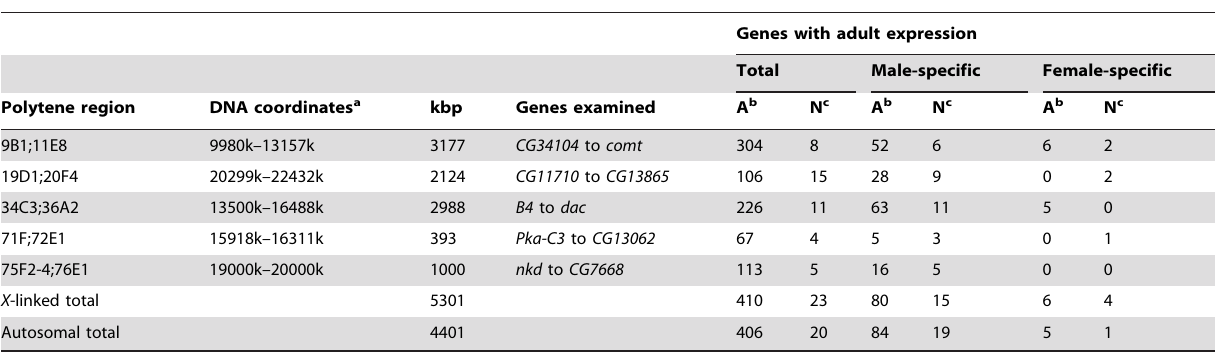
Table 7. Genes with sex-specific expression in adults.